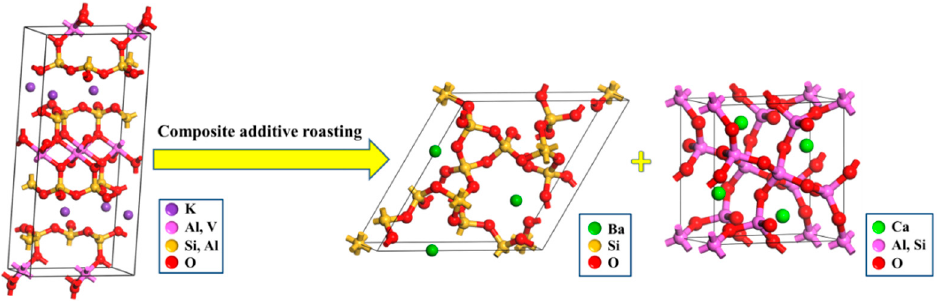
Figure 6. XRD patterns of roasting samples at different roasting temperature. ( A ) Roasting at 650 °C; ( B ) Roasting at 750 °C; ( C ) Roasting at 850 °C; ( D ) Roasting at 950 °C.